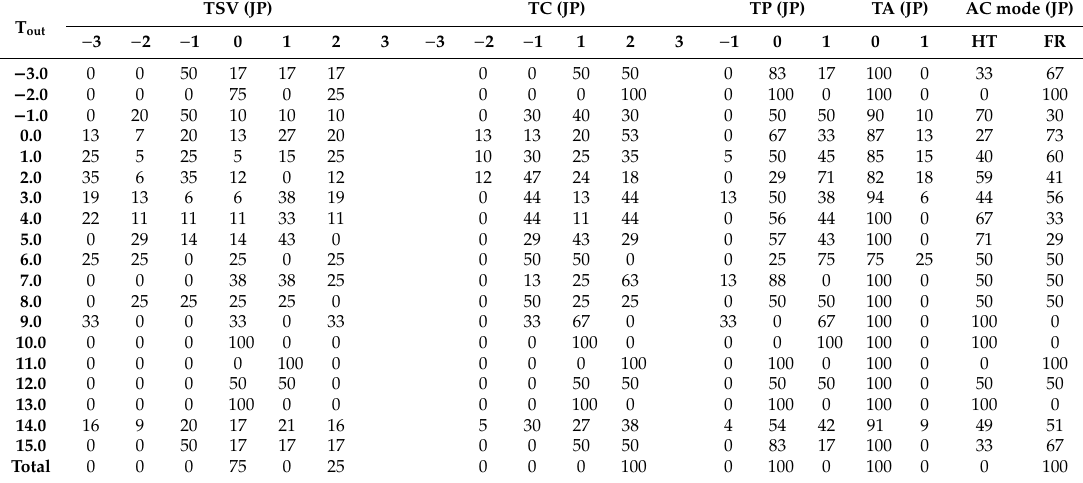
Table A4. Descriptive statistic: Thermal responses in relation to climate. Frequency distribution Japanese winter data points (%) N =